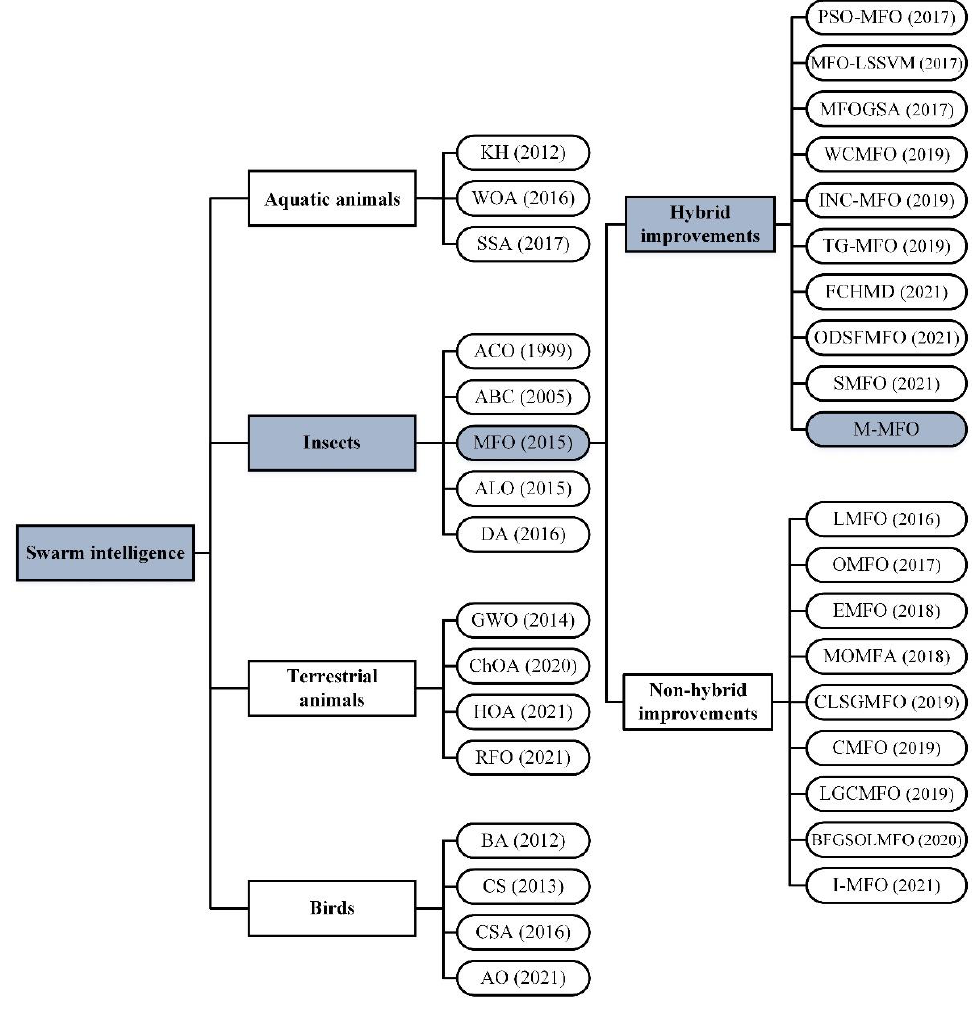
Figure 1. The classification of SI algorithms and variants of MFO.